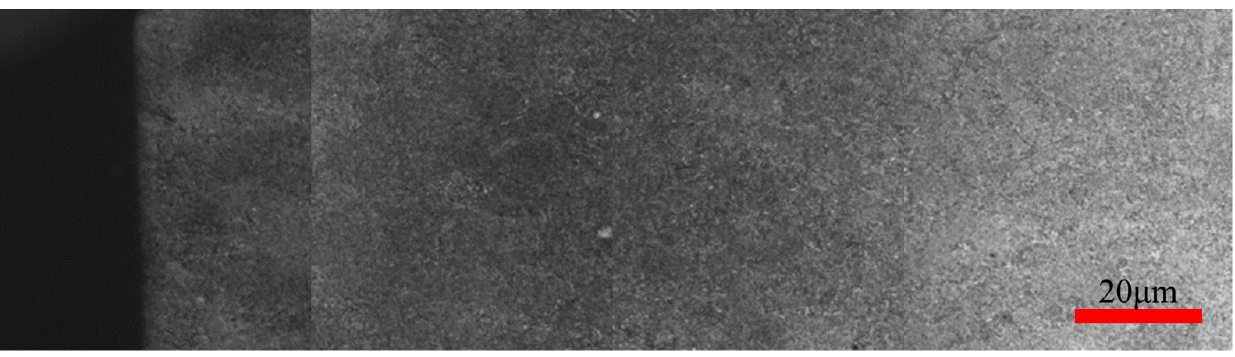
Figure 15. Carbon distribution on the side of the model.